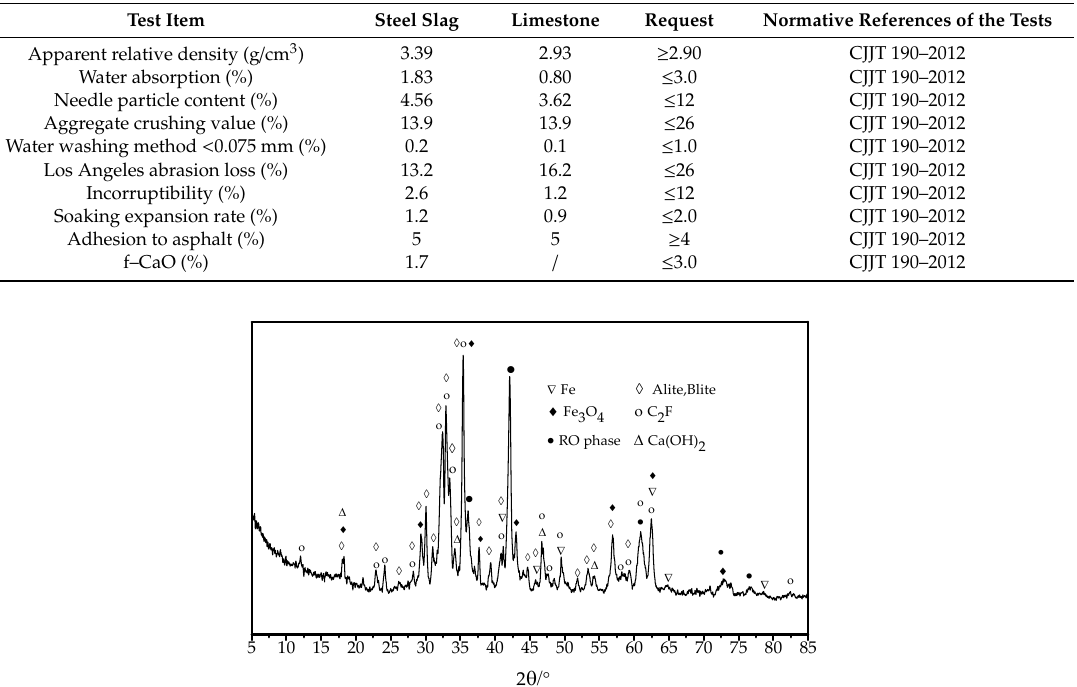
Table 2. Mechanical properties of the steel slag and limestone.